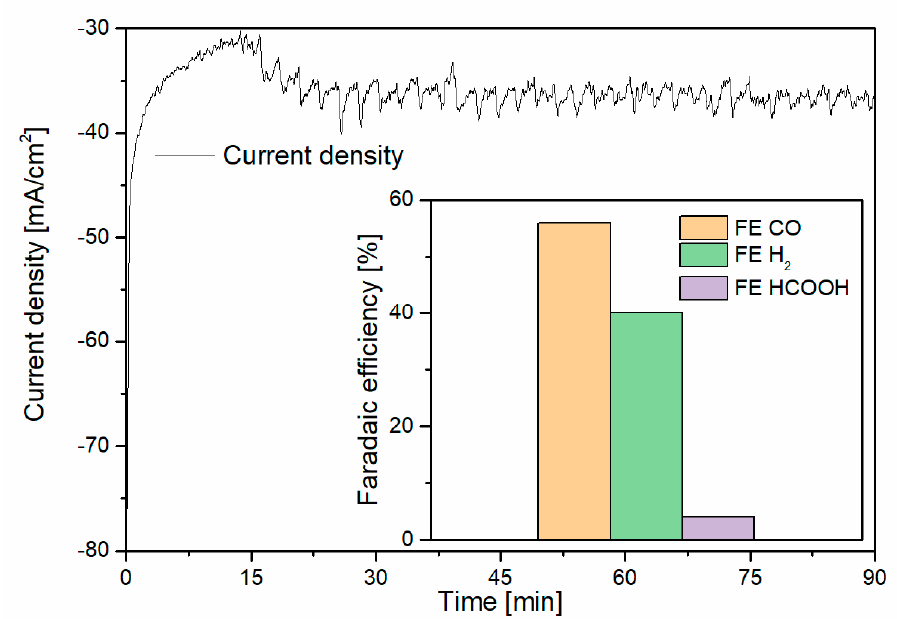
Figure 8. Conversion module results with an initial 50%/50% gas stream; average current density during the measure and (inset) faradaic efficiencies of the reaction products (FE = faradaic effi- ciency) .